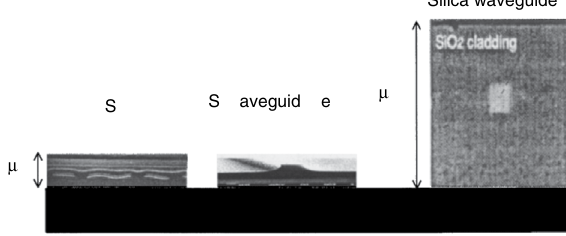
Figure 2 Advantage of the SOI waveguides in size compatibility with CMOS electronics, as opposed to silica waveguides